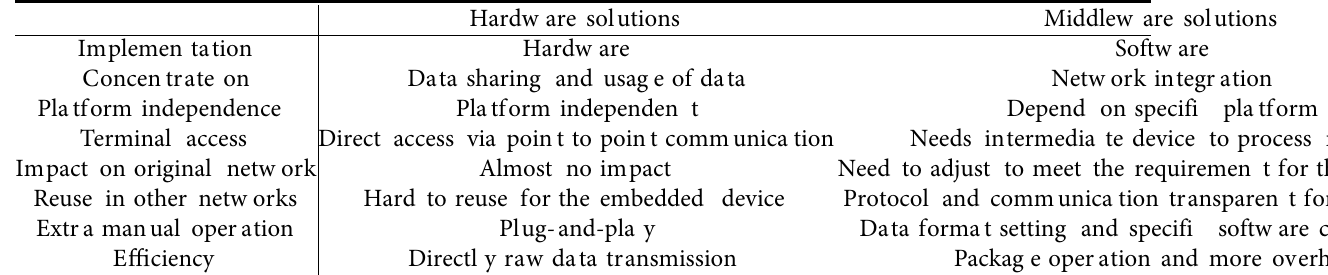
Table 3. Hardware solutions vs. Middleware